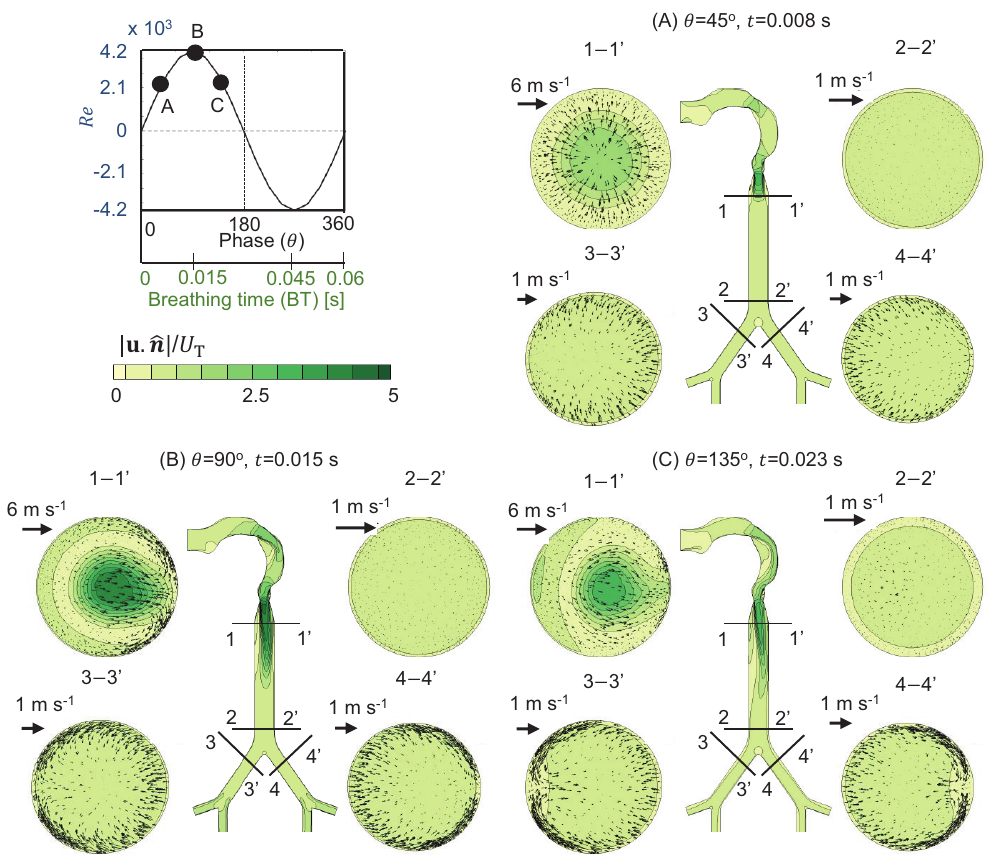
Figure 8. Contours of magnitude of plane-normal velocity component (non-dimensionalized with mean flow speed in trachea, U T ) with superimposed in-plane velocity vectors for Planes 1–4 at various time-points during inhalation for Wo = 24.1 at IT/BT = 50%. A is at Phase θ = 45 ◦ (=25% IT), B is at Phase θ = 90 ◦ (=50% IT), and C is at Phase θ = 135 ◦ (=75%